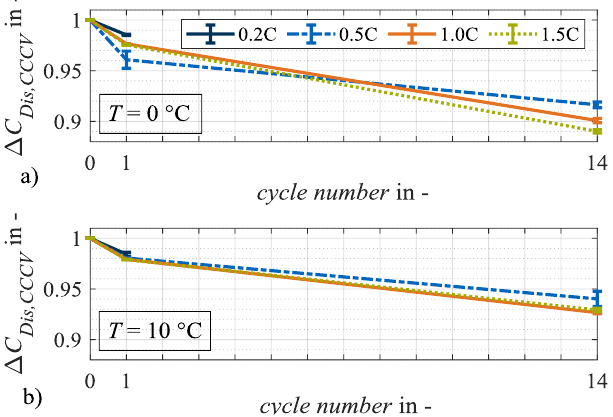
Figure 7. Relative changes in capacity ∆ C Dis,CCCV at test points with charge rates of 0.2C, 0.5C, 1.0C 1.5C after load cycles 1 and 14 at ( a ) 0 °C and ( b ) 10 °C. The error bars show the result deviation from and 1.5C after load cycles 1 and 14 at ( a ) 0 ◦ C and ( b ) 10 ◦ C. The error bars show the result deviation the two equally tested cell specimen. from the two equally tested cell